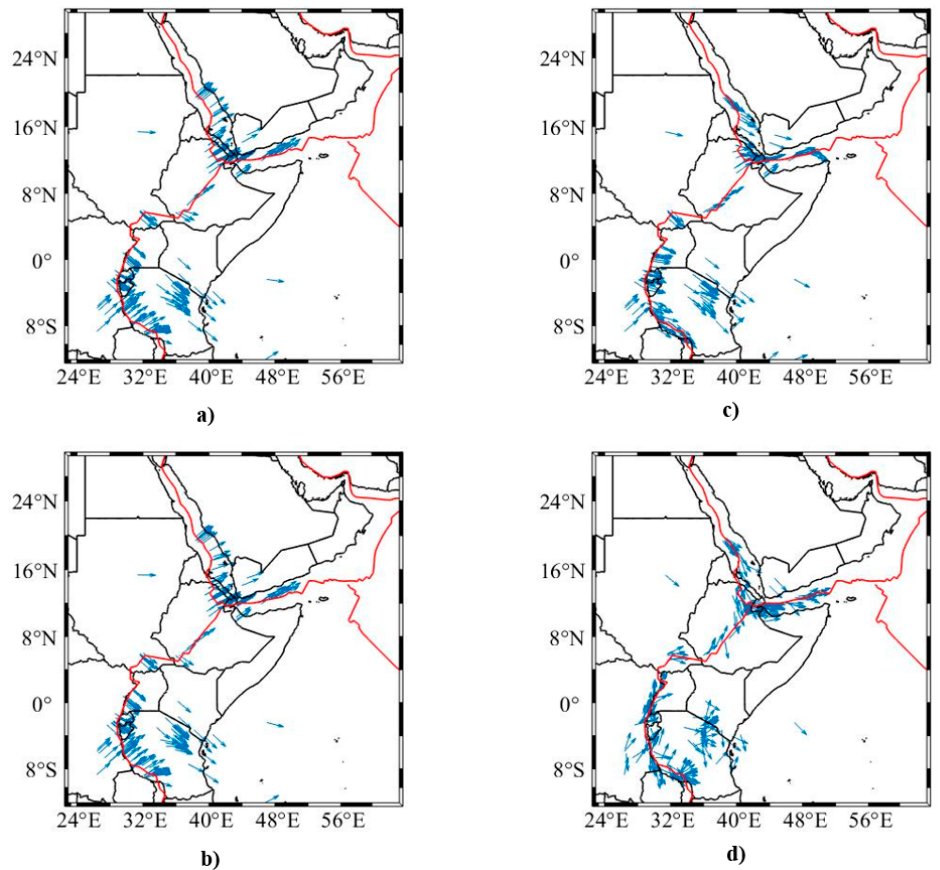
Figure 12. Maximum shear stress directions when the lower BVs are ( a ) the horizontal shear stresses due to mantle convection [4], ( b ) the horizontal shear and vertical stress due to mantle convection and plume, ( c ) vertical stress due to mantle plume, and ( d ) [42] data for the selected 17